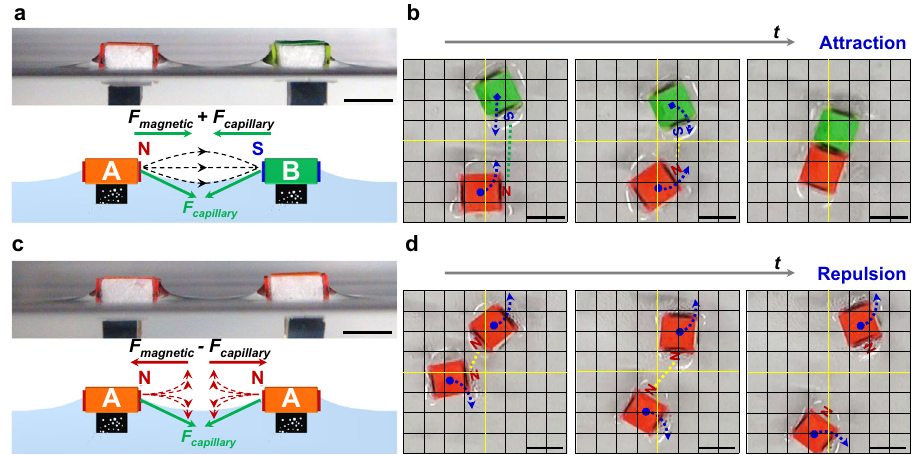
Fig. 2 | Rough force analysis of magnetic ( F magnetic ) and capillary ( F capillary ) interactions underlying the self-sorting of A-B and A-A. Photographs of a A-B and c A-A building blocks at air/water interfaces and schematic illustration of the